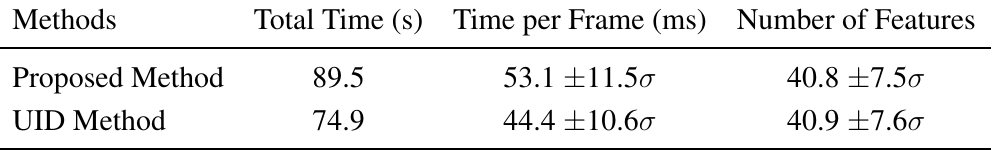
Table 1. Experiment (a): execution time and number of features into the system state.